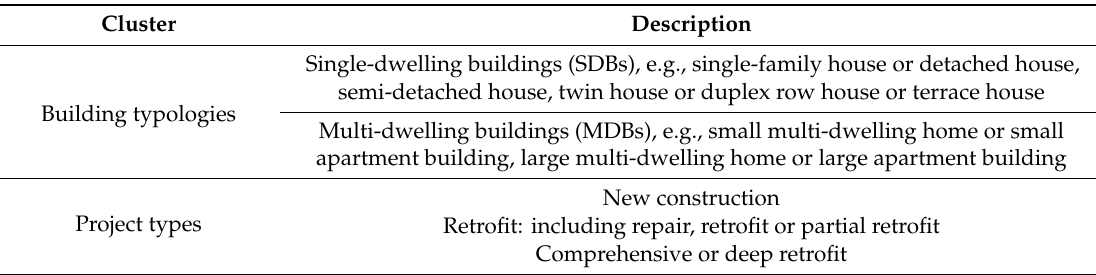
Table 2. Building typologies and project types: definitions and acronyms.